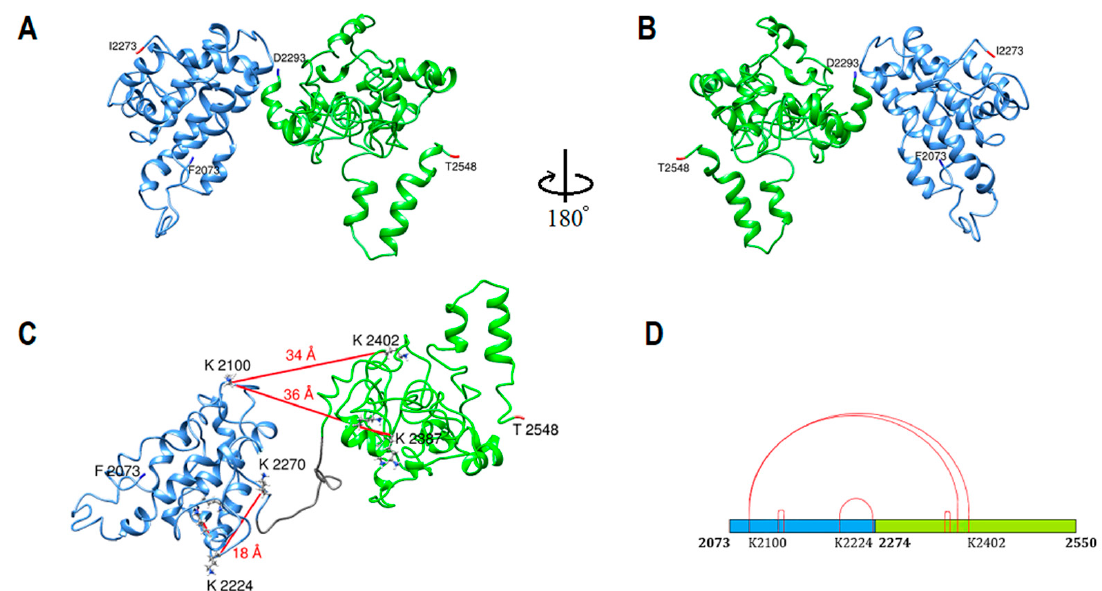
Figure 4. ApoB-100 subunit III structure and cross-link map. ( A , B ) Ribbon representation of ApoB-100 subunit III structure. Domain 1 (blue) begins at F2073 and extends to I2273. The shorter form of domain 2 (green) begins at D2293 through T2548. The entire structure is composed of helix-turn-helix motifs. Both domains were generated by MODELLER using apolipoproteins as templates. ( C ) DSSO cross-link on subunit III ribbon representation with five intra-subunit cross-links (red lines) between lysine residues. Two cross-links between K2100-K2387 and K2100-K2402 exceeded the expected 26 Å limit. ( D ) DSSO cross-link map on subunit III linear sequence with two domains is colored according to C without considering the coil sequence that connects domain 1 to domain 2.